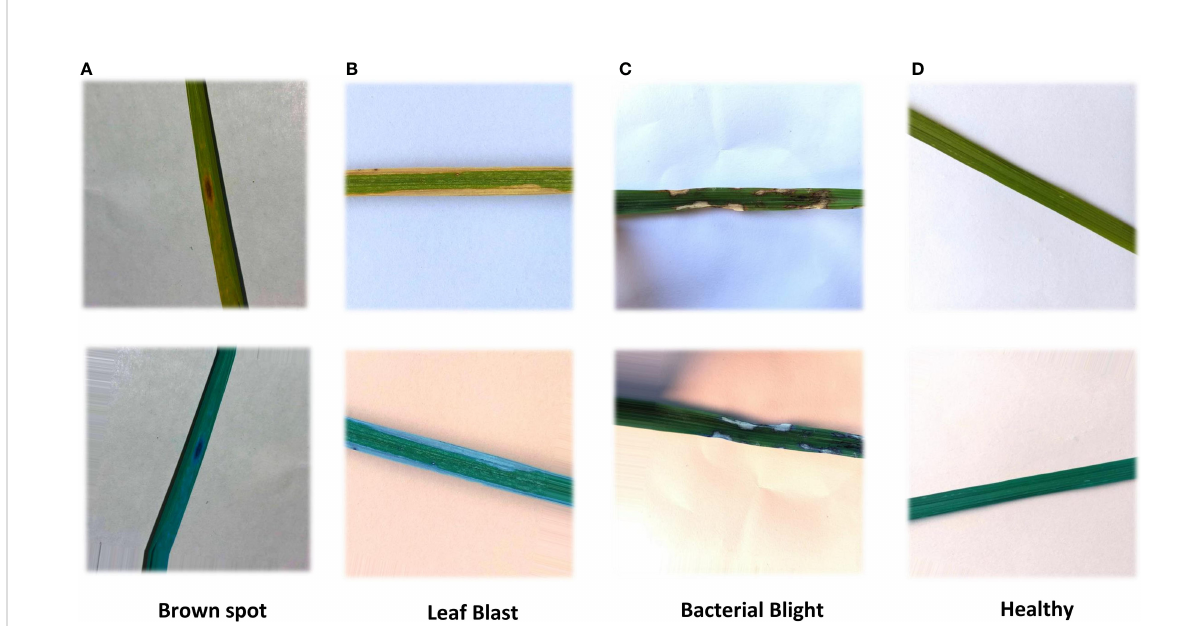
FIGURE 2 Rice images with random image enhancement. The enhancement includes horizontal fl ip, vertical fl ip, scaling horizontal offset, vertical offset, and shear transform. (A) Brown spot (B) Leaf Blast, (C) Bacterial Blight, (D) Healthy.